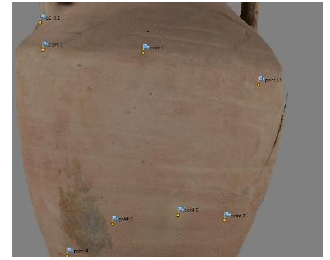
Figure 9. 3D model of the Knidean